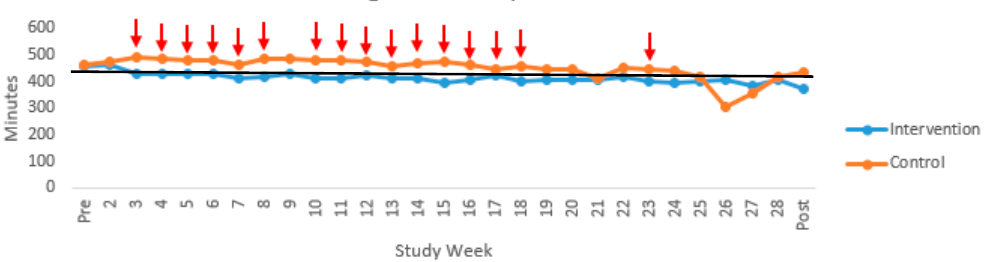
Figure 2. Nighttime sleep duration trajectory with marked study group assignment differences. Note. = significant/trending study group assignment differences; ____ = 7 h.